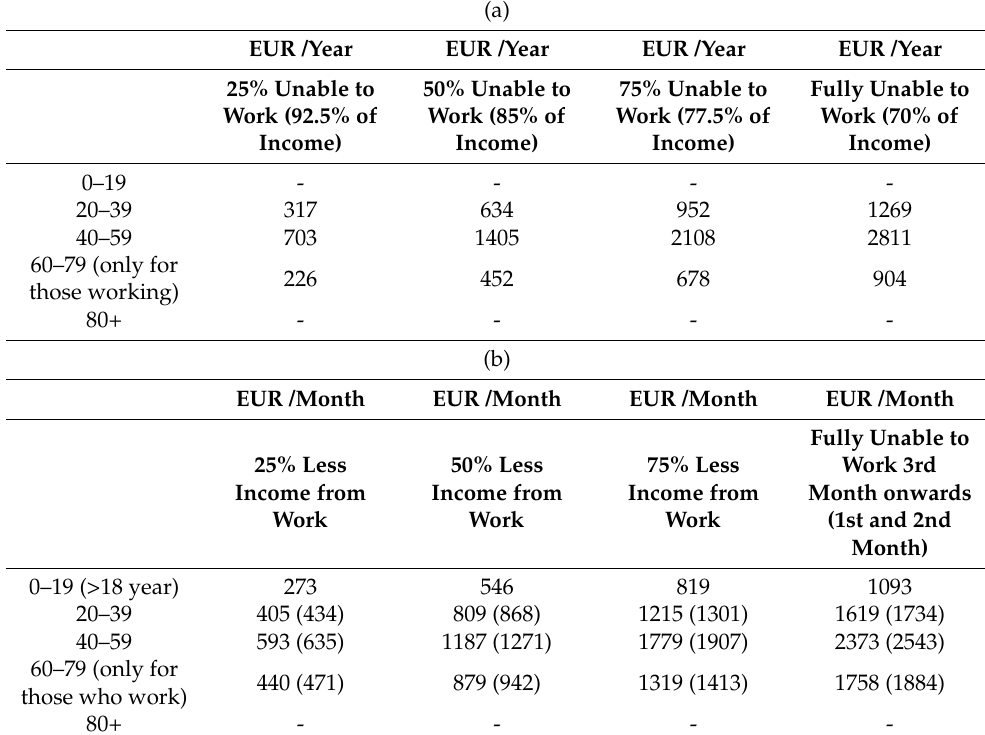
Table A6. (a) Estimated loss of tax revenue due to morbidity per individual per year for different levels of work disability. (b) Added social benefits to be paid due to different levels of morbidity per individual per